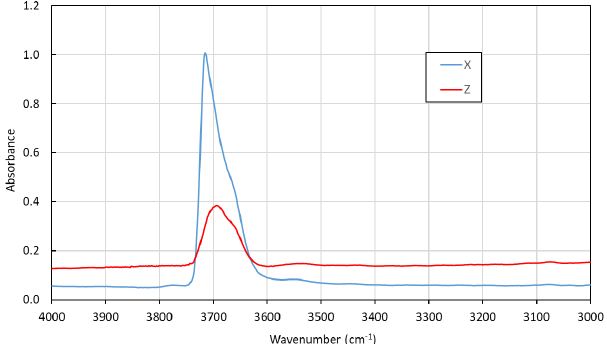
Figure 5. Raman spectrum of ferri-taramite, obtained with a 514nm laser. Figure 6. Polarized single-crystal FTIR spectra of ferri-taramite. Sample thickness is